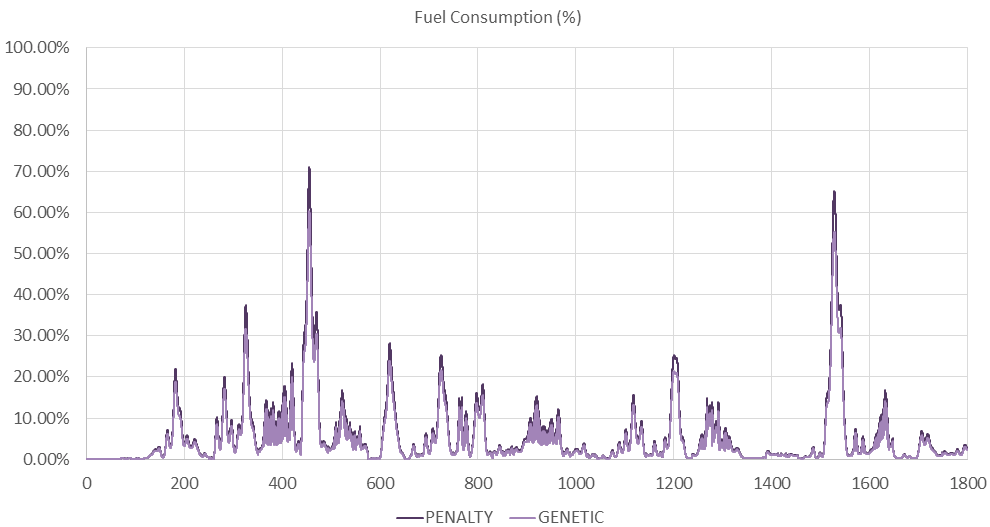
Figure 17. Fuel Consumption Time Histories Compared to Maximum Capacity by Penalty Programming and Genetic Algorithm.